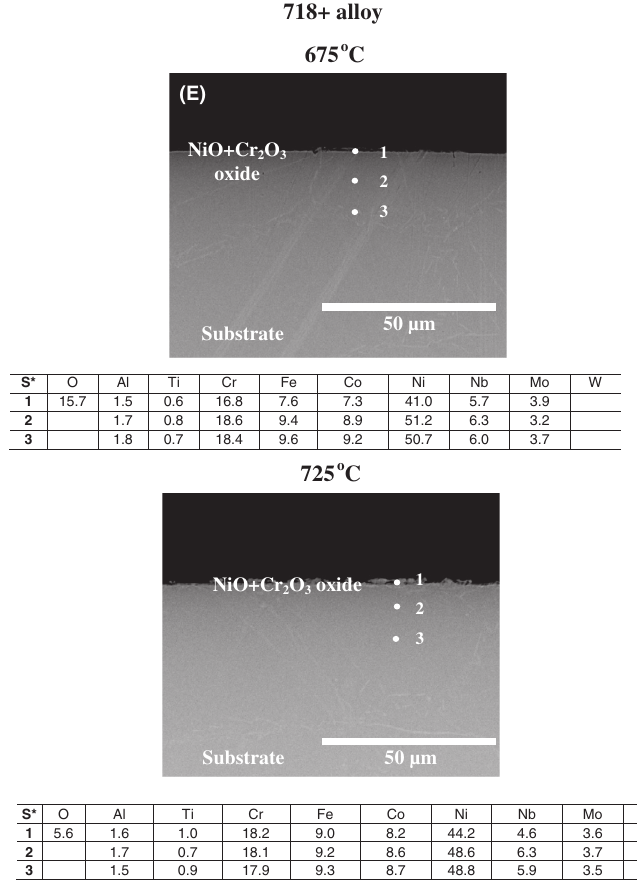
Austenitic steels TP347HFG and HR3C alloys formed much thinner oxides as ferritic steels. The formed